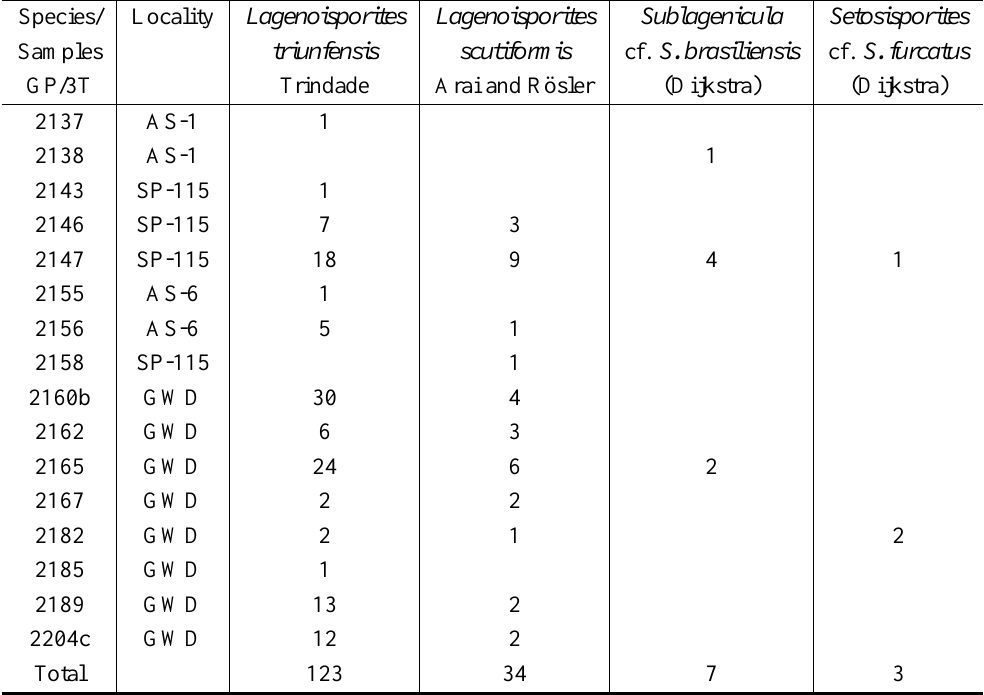
Occurrence of megaspore species identified, with number of specimens per